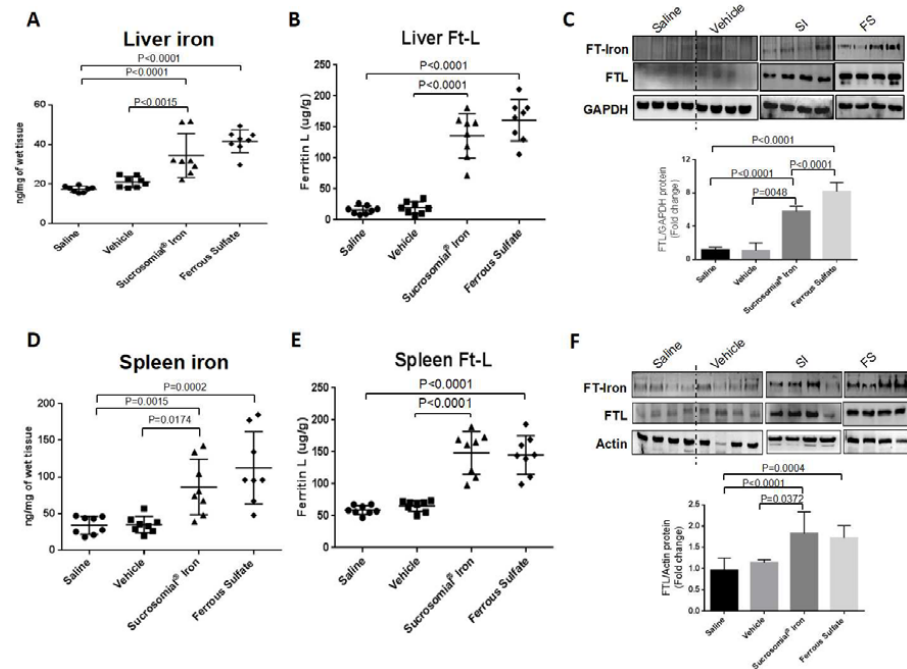
Figure 3. Anemic mice treated with Sucrosomial ® Iron and Ferrous Sulfate showed increased body iron stores. ( A ) Liver and ( D ) spleen iron contents were quantified in all groups of mice treated with Saline, Vehicle, Sucrosomial ® Iron and Ferrous Fulfate (1 mg/kg) by gavage for two weeks. ( B ) and ( E ) ELISA assay for the quantification of L -ferritin in liver and spleen. In ( A ), ( B ), ( D ) and ( E ) Saline (circles), Vehicle (squares), Sucrosomial ® Iron (triangles) and Ferrous Sulfate (diamonds).; ( C ) and ( F ) Representative image of Prussian blue stain plus DAB enhancement of ferritin-iron (FT-Iron) (top) and representative image of Western blotting for L -ferritin in liver and spleen of treated mice. The densitometry was performed using ImageJ. The values ( N = 3) were normalized to GAPDH or actin for liver and spleen respectively. p values were obtained by one-way ANOVA.